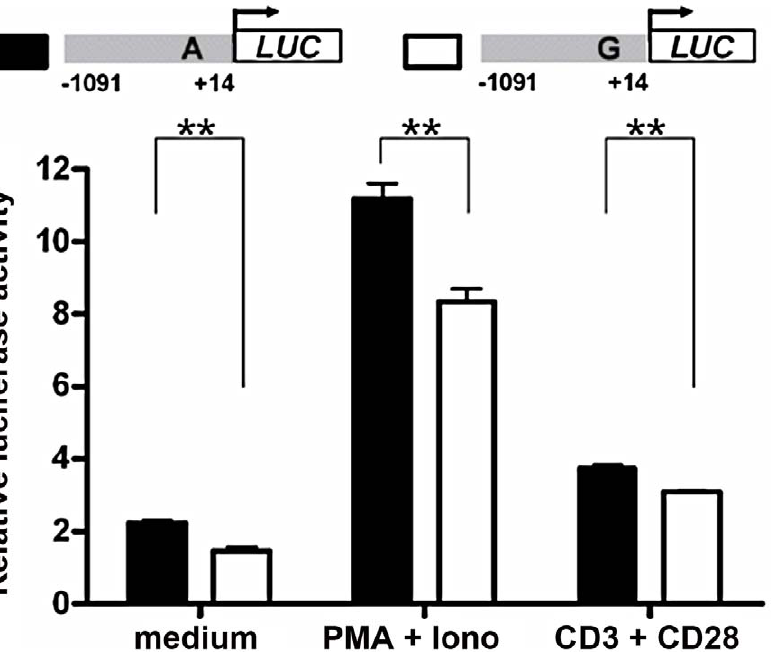
Figure 2. Allelic difference of rs57095329 in miR-146a promoter activity. Shown is a schematic representation of reporter gene constructs driven by the full-length miR-146a promoter containing one or other of the rs57095329 alleles ( upper ) and the relative luciferase activity of the two constructs in Jurkat cells in both the steady (medium) and activated states ( lower ). For activation, the cells were stimulated with PMA + Iono or with anti-CD3 + anti-CD28 antibodies for 6 hours (see Materials and Methods). The data shown are means 6 SEM and are representative of three independent experiments performed in triplicate. ** indicates P , 0.01.